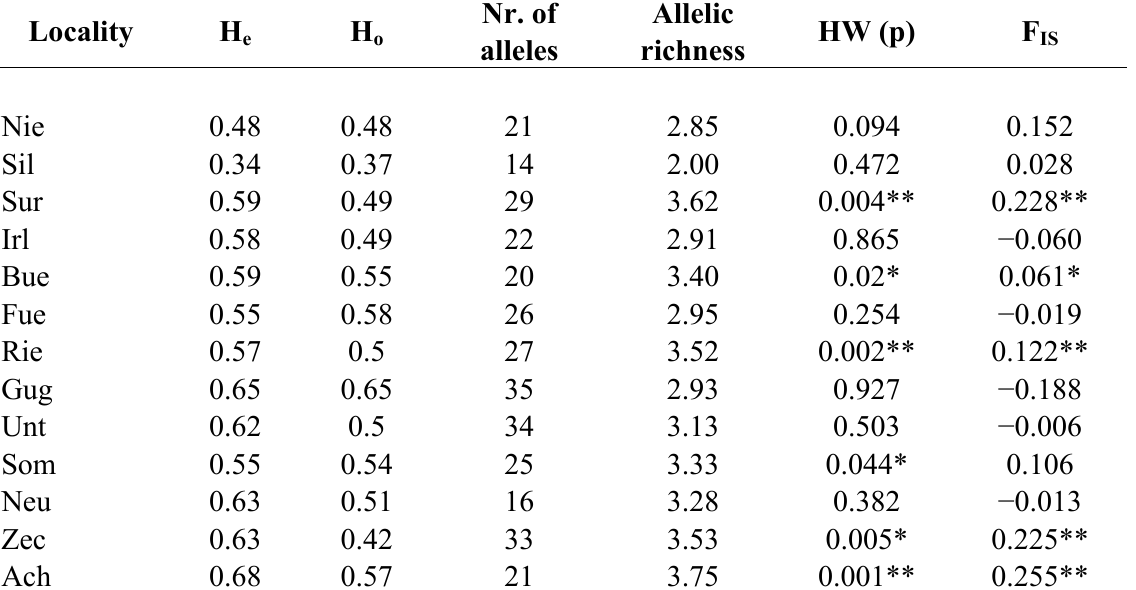
) and observed (H ) heterozygosity, number of alleles, Table 2. Average expected (H e o allelic richness, probability of Hardy-Weinberg disequilibrium (heterozygote deficit) per locality, average F per locality. Single asterisks (*) indicate significant, double asterisks IS (**) highly significant results; population Kop was not